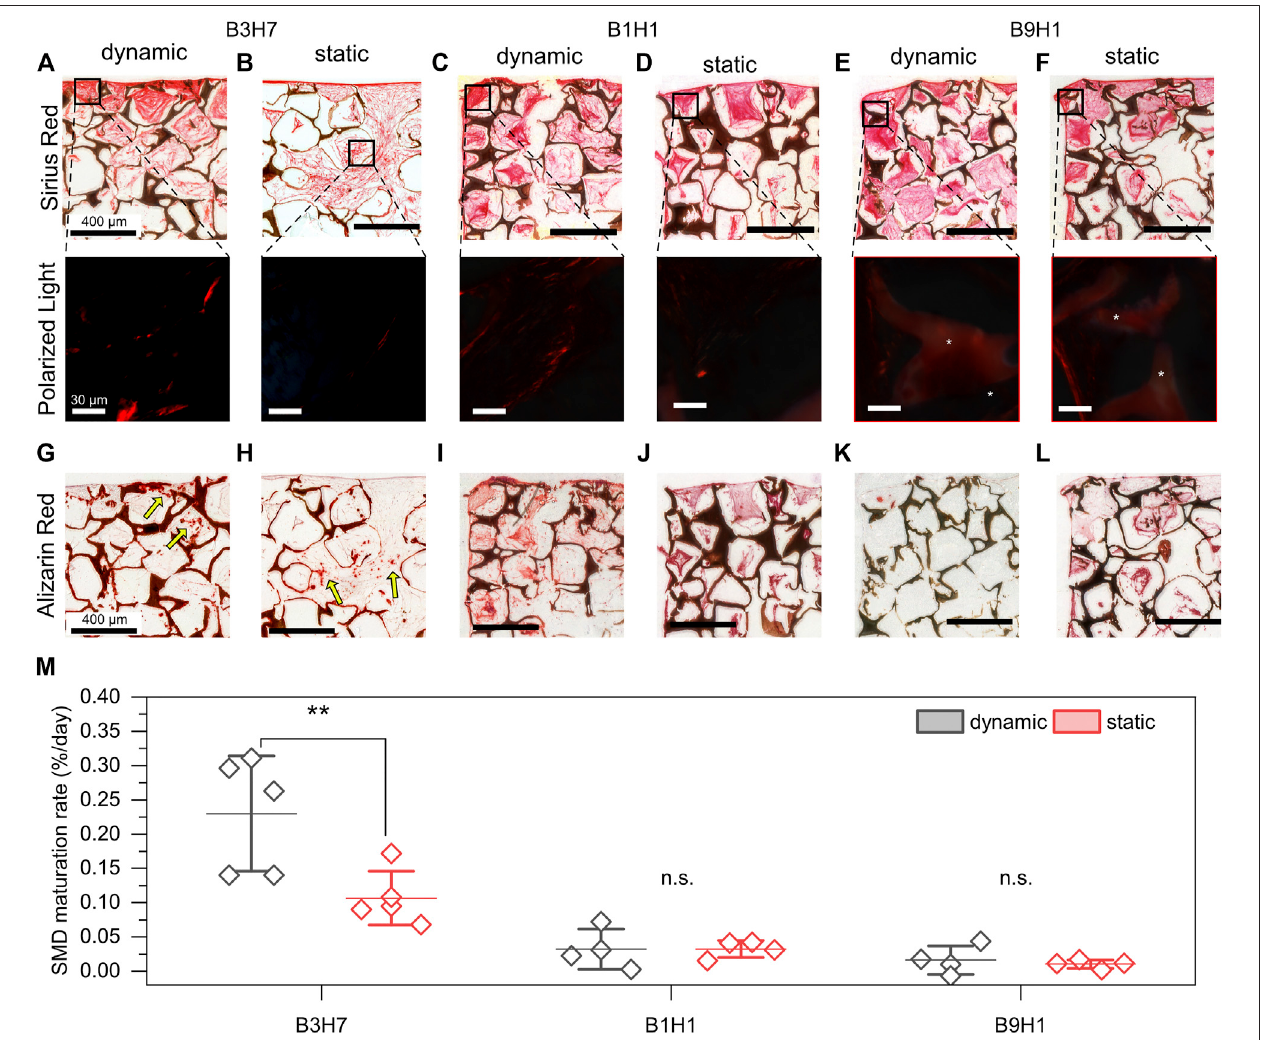
FIGURE 6 | Extracellular matrix mineralization after 7 weeks in dynamic compression bioreactors. (A-F) Vertical cross-sections stained with Picro Sirius Red of B3H7, B1H1, and B9H1 nanocomposite scaffolds under static (B,D,F) or dynamic (A,C,E) conditions. The magni fi cations show a birefringent collagenous matrix imaged with polarized light microscopy. The white asterisk indicates the scaffold. (G-L) Sequential cross-sections of the same nanocomposite scaffolds stained with Alizarin Red. N = 2 samples were processed for the stainings. (M) Scaffold mineral density maturation rate was monitored by time-lapsed micro-CT imaging of B3H7 (n = 5), B1H1 (n = 4) scaffolds, and B9H1 (n = 4) scaffolds. A statistically signi fi cant difference was tested by a two-way repeated measurements ANOVA with Holm-Bonferroni post-hoc correction, ** p < 0.01, n.s. no signi fi cant change. The B3H7 rates are from Schädli et al., 2021.